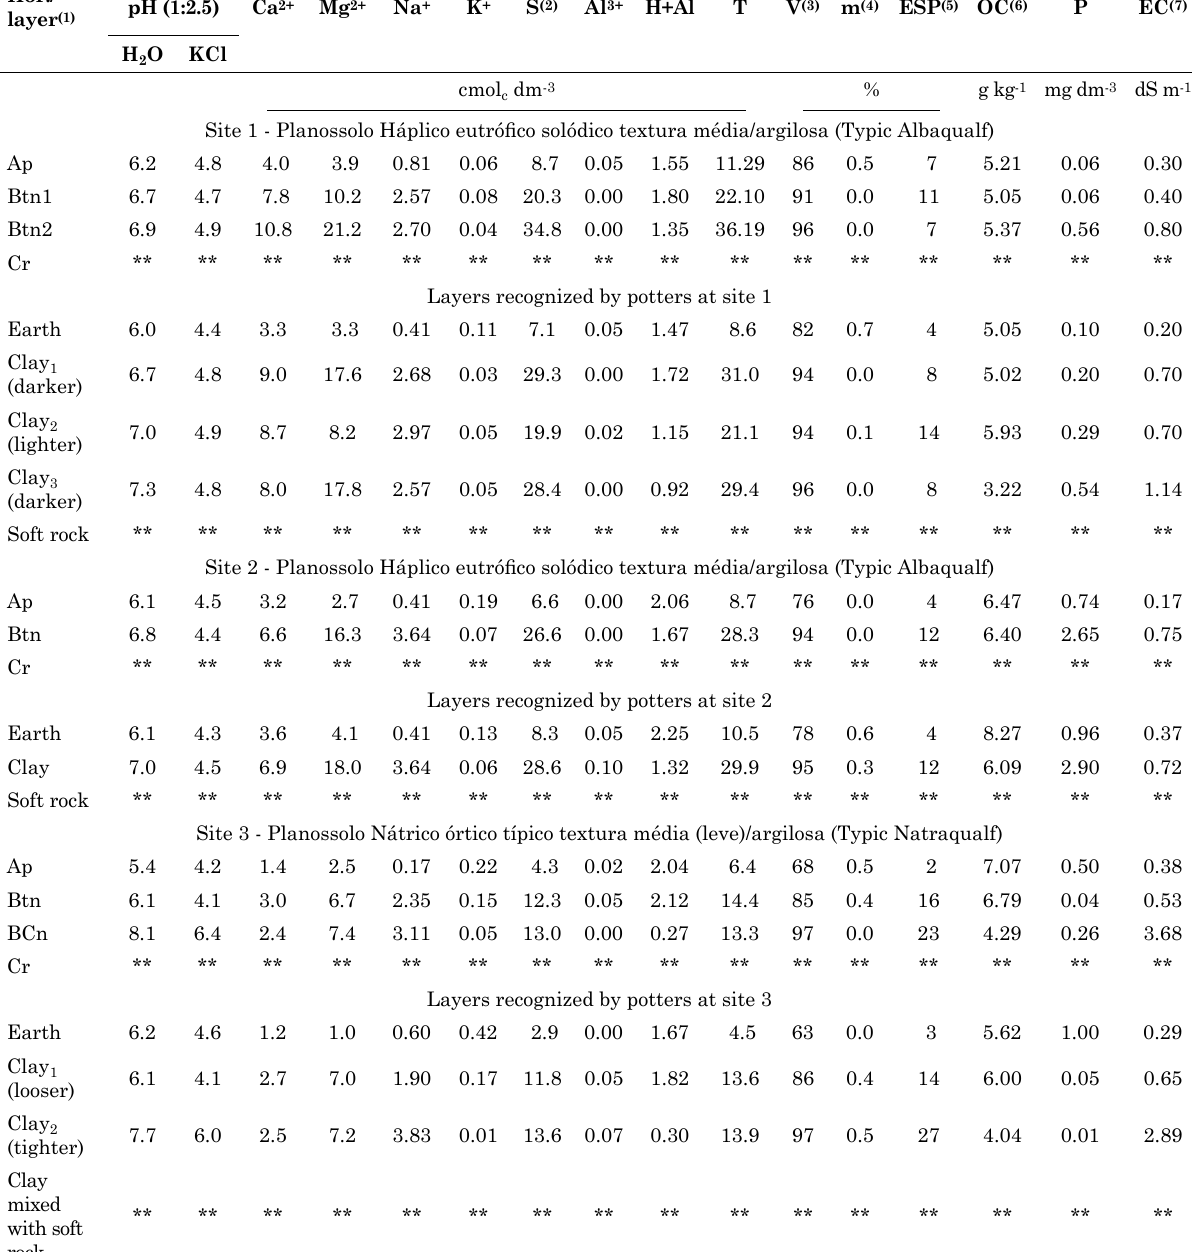
table 3. chemical properties of soils used as a source of “red clay” by peasant potters in altinho, Pernambuco, brazil Hor./ layer